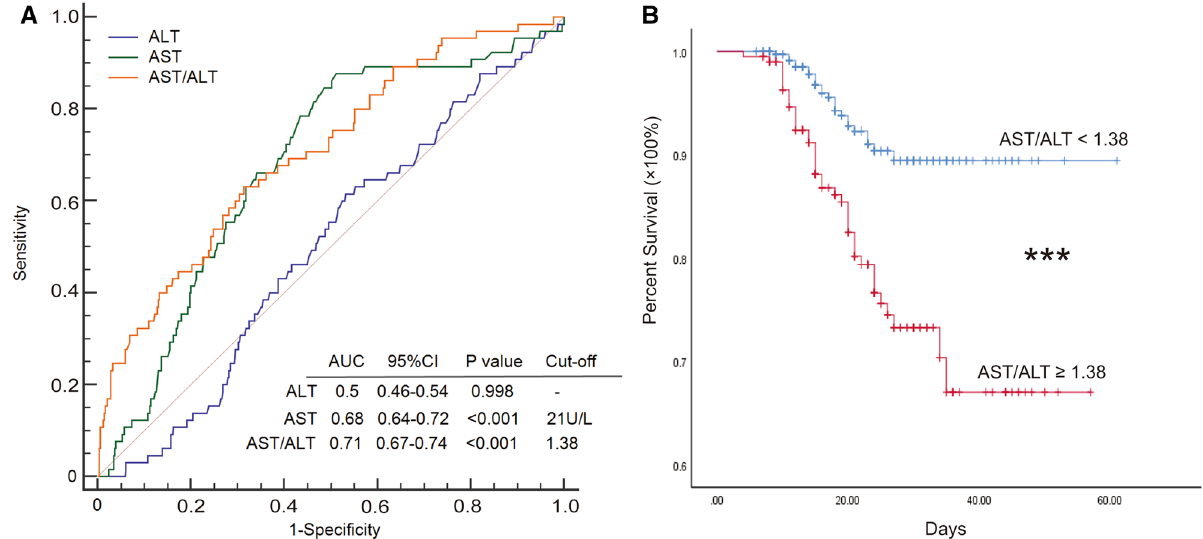
Figure 1. AST/ALT ratio distinguished COVID-19 patients with different prognosis. Only patients with clear endpoints (recovery and death) were involved in the analysis about prognosis (n = 555). ( A ) Receiver operating curve (ROC) was utilized to compare the ability of ALT, AST, and AST/ALT ratio to predict death in hospitalized COVID-19 patients. Cut-off values were determined through Youden index. ( B ) Kaplan–Meier survival analysis in patients with AST/ALT < 1.38 and ≥ 1.38. AUC area under the curve; ***P < 0.001.